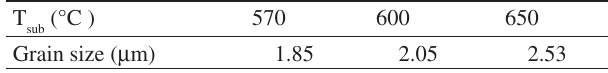
Table 4. Grain size of CdTe films deposited at T different substrate temperatures.